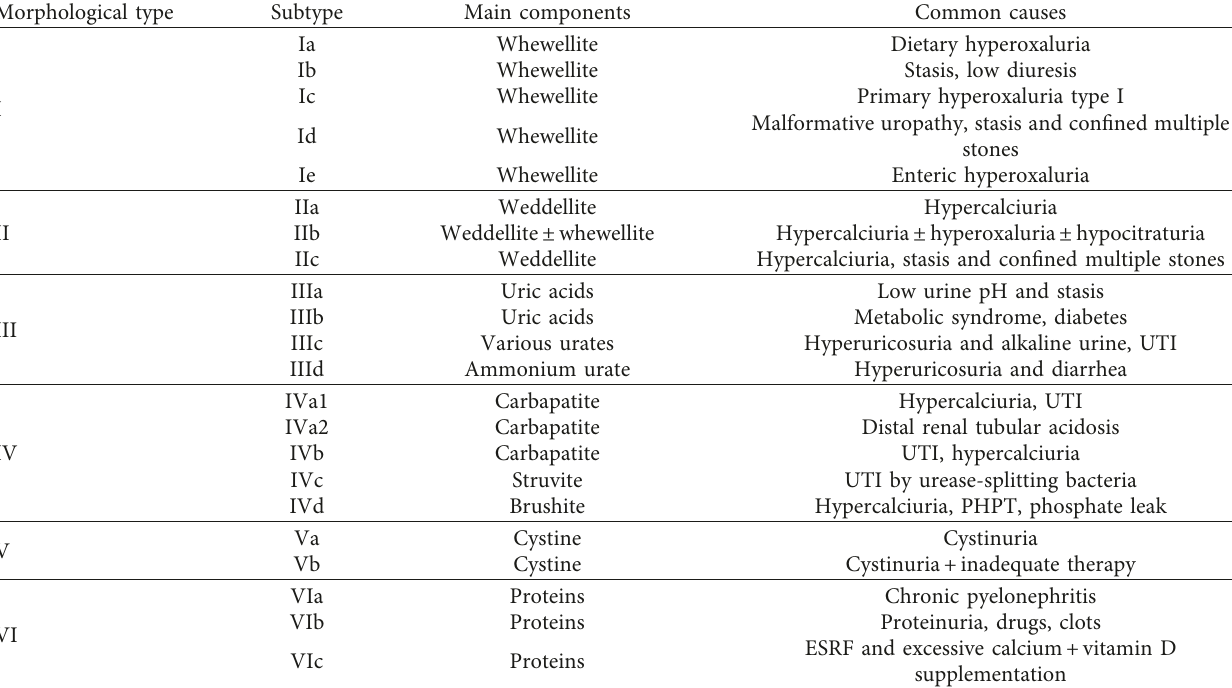
Table 1: Morphocostitutional classification of renal stones developed by Daudon et al. Morphological